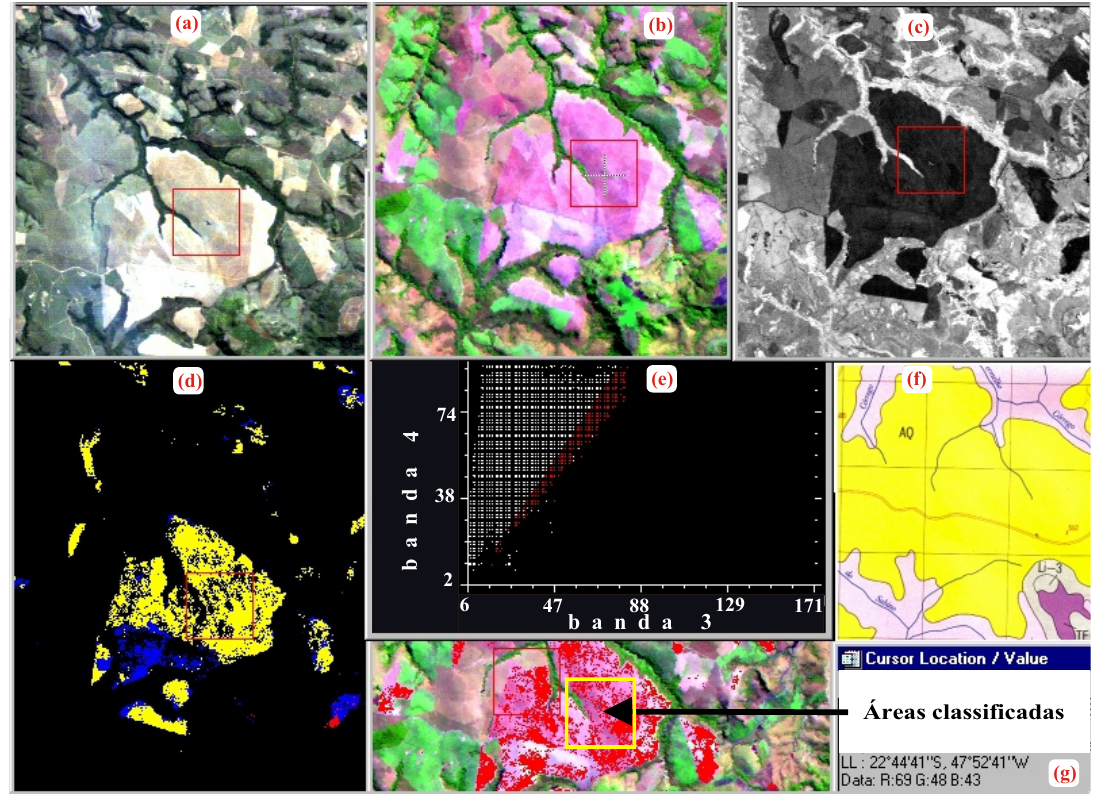
Figura 3. Ilustração da metodologia: (a) Composição 3R, 2G, 1B; (b) Composição 5R, 4G, 3B; (c) Imagem do índice de vegetação SAVI; (d) Imagem classificada discriminando as classes de solo (RQ-amarelo; PV-azul; LR-vermelho); (e) Gráfico com a dispersão da reflectância relacionada com as bandas 4 e 3 (pontos a 45 graus no gráfico são relativos à Linha do Solo) e imagem com pixels marcados (vermelho) indicando solo exposto. (f) Limites do mapa de solos. (g) Coordenadas do ponto indicado pelo cursor e posteriormente localizados no